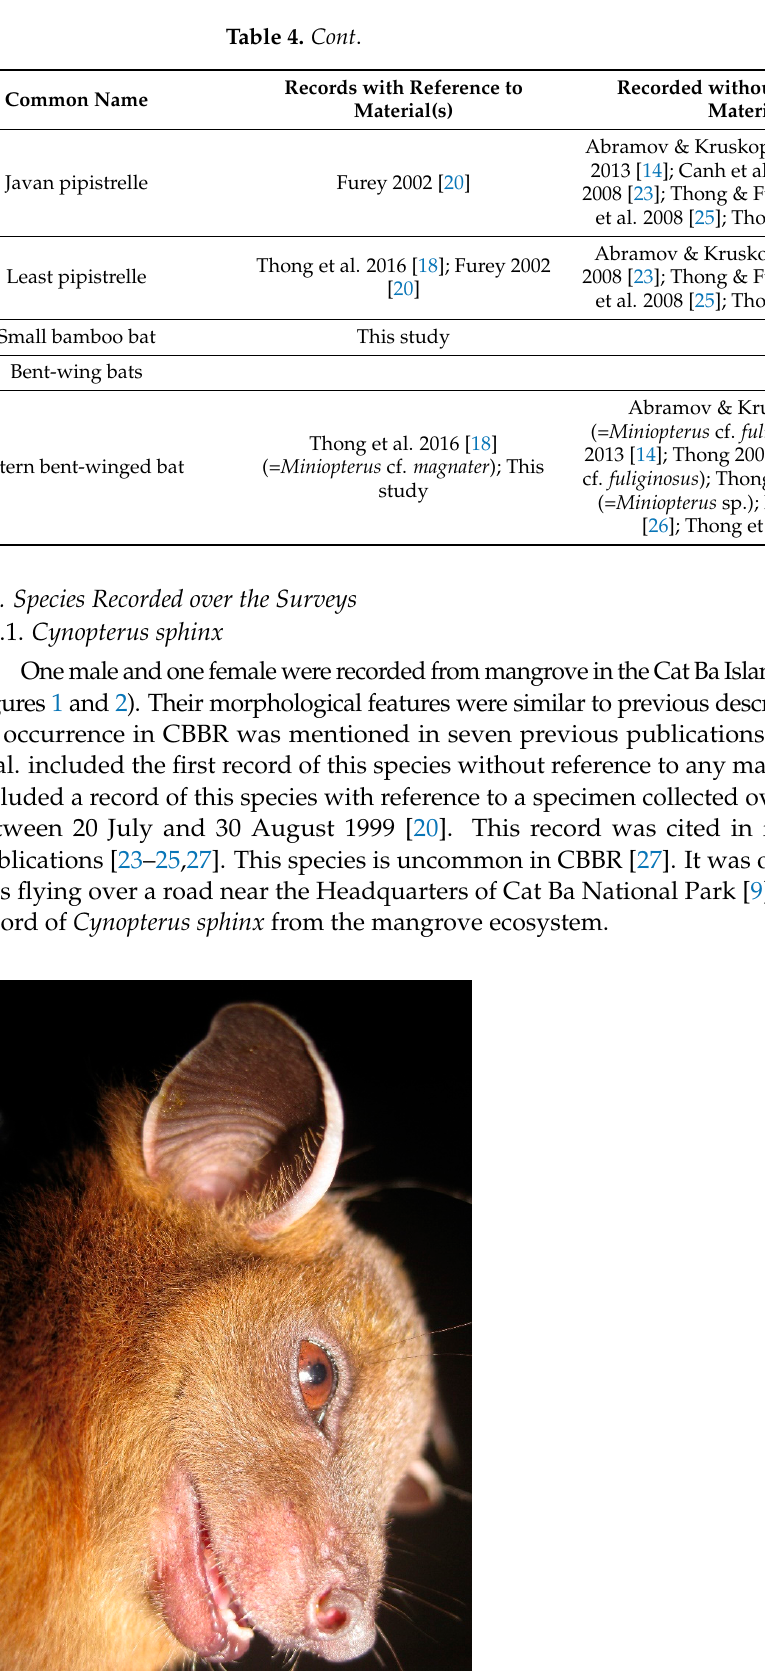
Figure 2. Cynopterus sphinx , adult male. Photograph by Vu Dinh Thong.